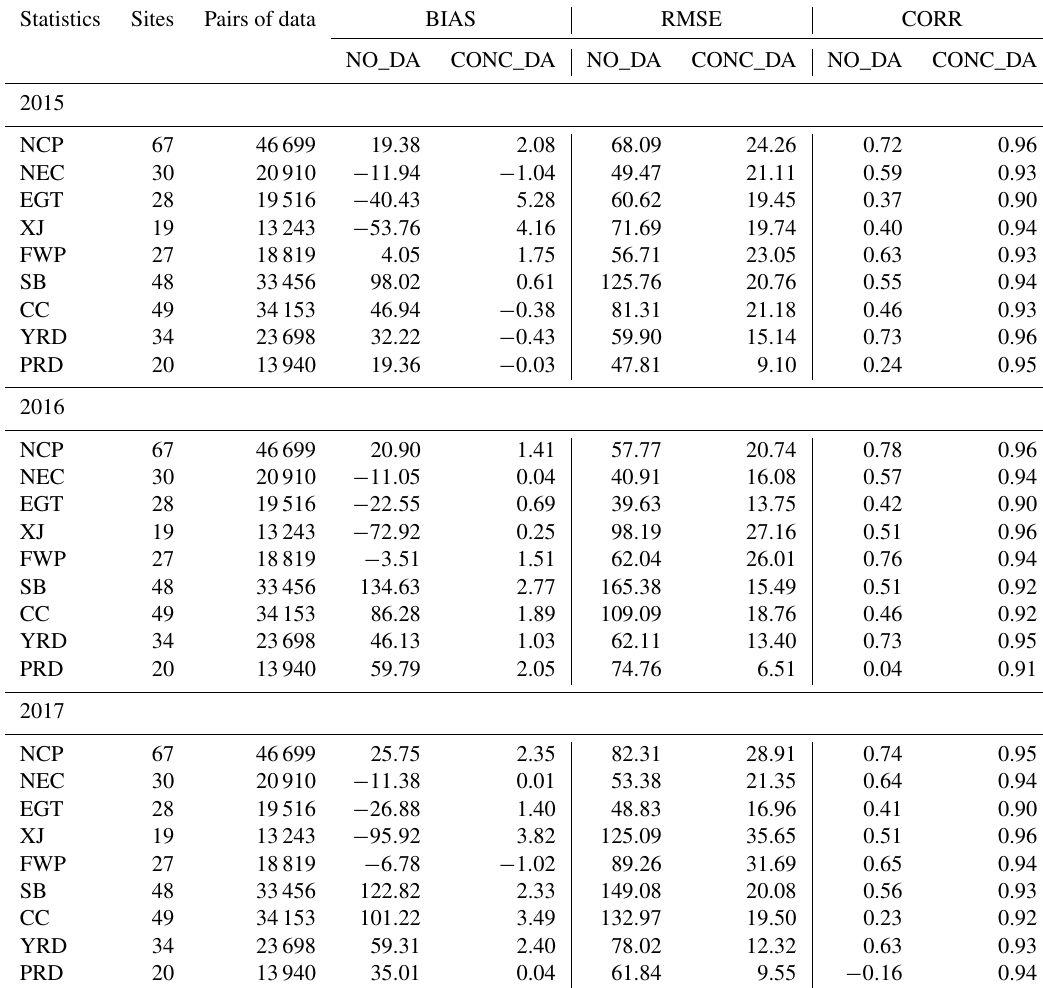
Table 3. Statistics of the observed and model-simulated surface PM 2 . 5 for January 2015, 2016 and 2017 in nine regions (units are µgm − 3 for BIAS and